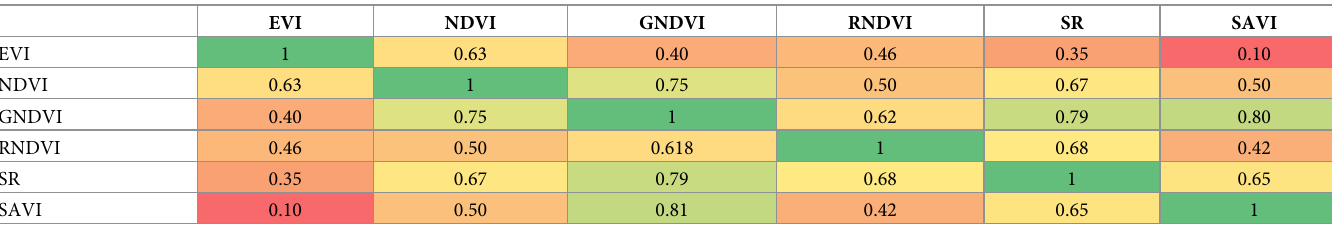
Where, yˆ = estimated rate; y = mean observed rate; y = measured ones; N = number of observations with i = 1, 2 . . . n.